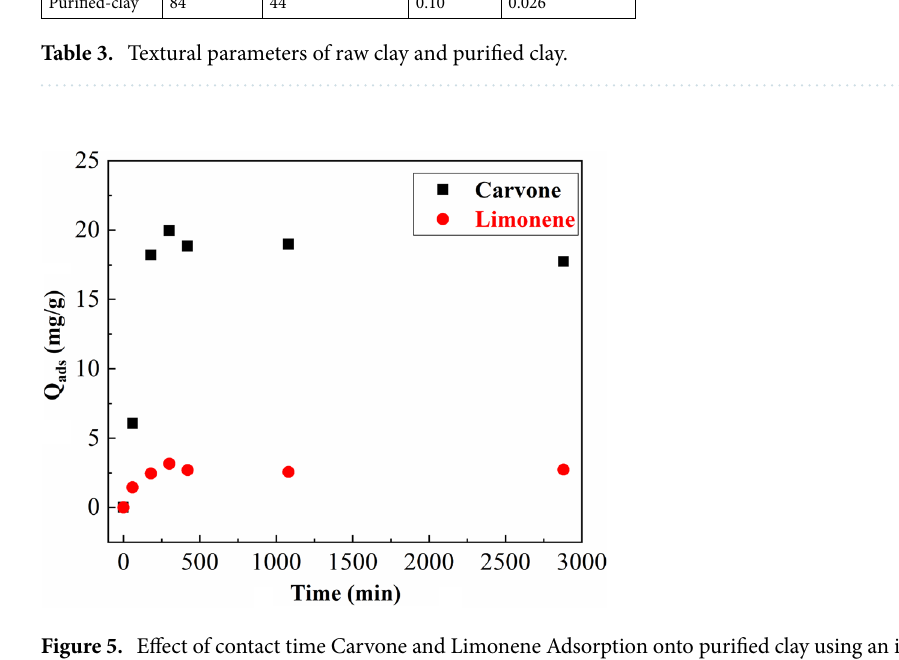
Figure 5. Effect of contact time Carvone and Limonene Adsorption onto purified clay using an initial CEO concentration 130 mg/mL at T = 25